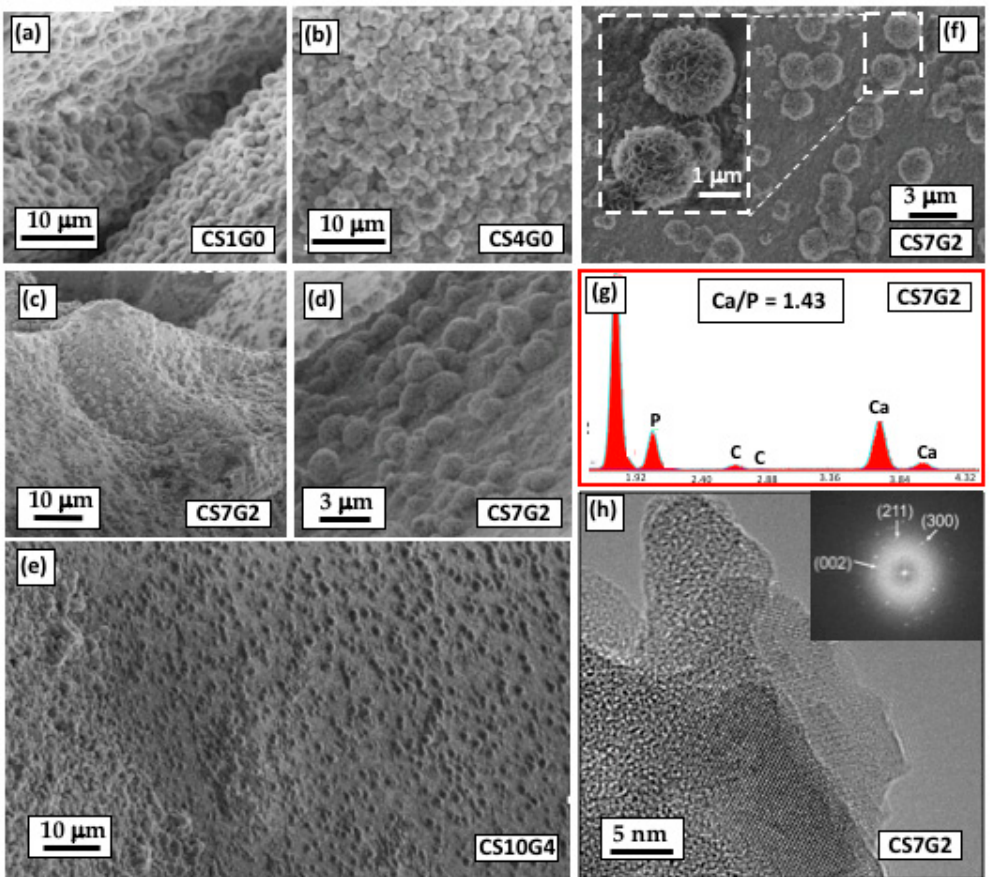
Figure 7. SEM micrographs of the apatite formed on the surfaces of the following hybrid aerogels soaked in SBF for 21 days: ( a ) CS1G0; ( b ) CS4G0; ( c ) CS7G2; ( d ) magnification of precedent micrograph for CS7G2; ( e ) CS10G4; ( f ) CS7G2; ( g ) EDS spectrum from CS7G2 from which Ca / P molar ratio 1.43 was found; ( h ) HRTEM micrograph of CS7G2 and corresponding SAED pattern